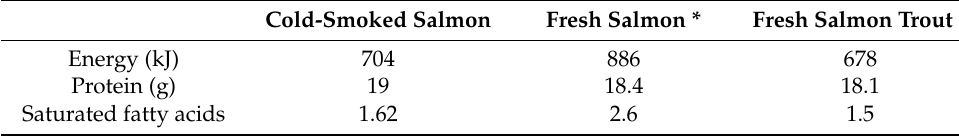
Table 5. Selected nutritional value of selected fish (in 100 g) and their Nutri-Score index. Cold-Smoked Salmon Fresh Salmon